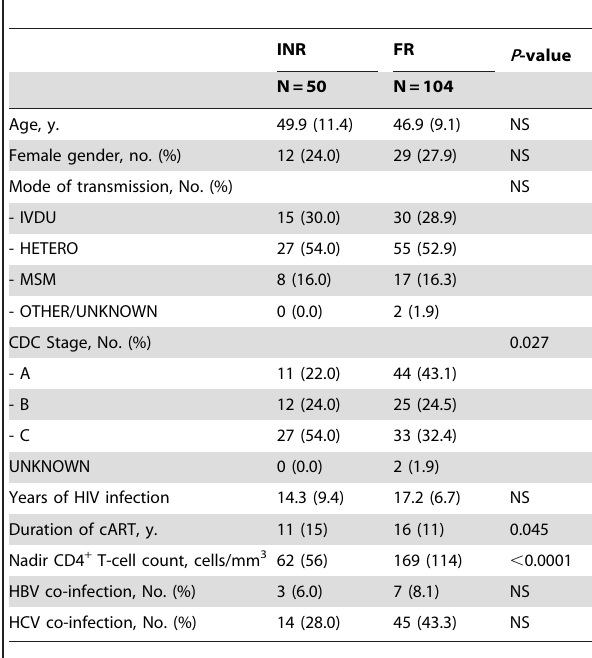
Table 1. Demographic and viro-immunological characteristics of 154 HIV-1-infected patients, according to immunological response to combination antiretroviral